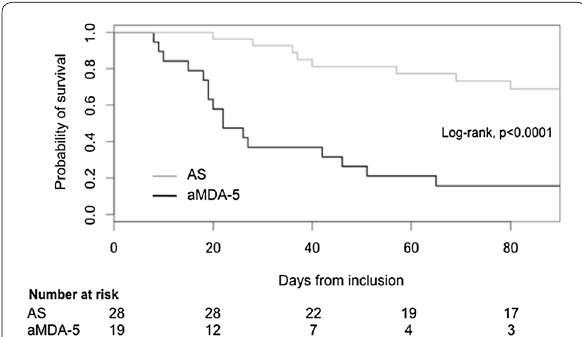
Fig. 1 Kaplan–Meier graph of the probability of survival from ICU admission to day 90 in patients with dermato‑pulmonary syndrome associated with anti‑MDA‑5 antibodies (black curve) and patients with anti‑synthetase syndrome (gray